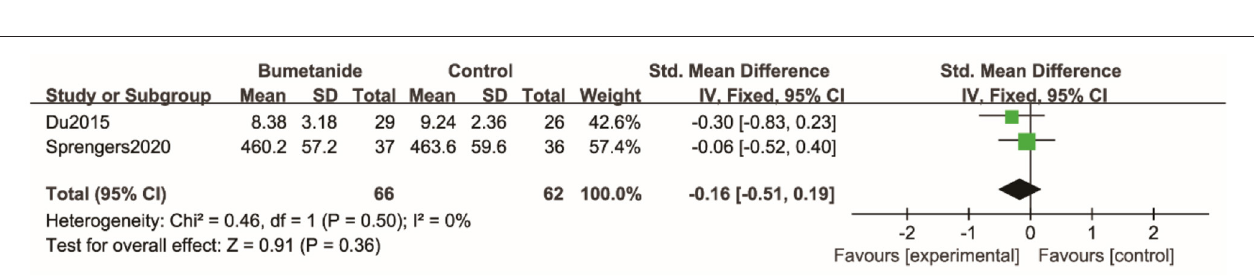
children with ASD, but it does not have strong evidence-based